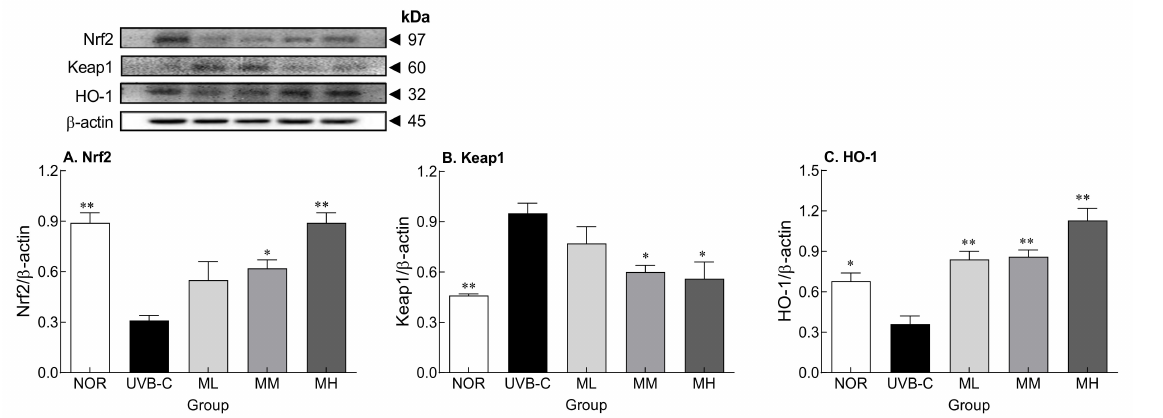
Figure 5. Effects of milk phospholipids on protein expression of Nrf2 ( A ), Keap1 ( B ), and HO-1 ( C ) in UVB-irradiated hairless mice. Western blot and protein quantifications are shown. NOR: oral administration of saline without UVB irradiation; UVB-C: oral administration of saline under UVB irradiation; ML: oral administration of low-dose (50 mg/kg b.w.) milk phospholipids under UVB irradiation; MM: oral administration of medium-dose (100 mg/kg b.w.) milk phospholipids under UVB irradiation; MH: oral administration of high-dose (150 mg/kg b.w.) milk phospholipids under UVB irradiation. Data are expressed as means ± standard error ( n = 6). * p < 0.05 and ** p < 0.01 vs. UVB-C group (Tukey’s test). Nrf2: Nuclear factor erythroid-2-related factor 2; Keap1: Kelch-like ECH-associated protein 1; HO-1: heme